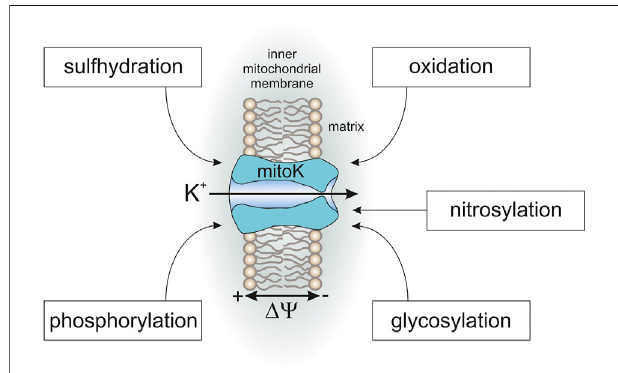
FIGURE 3 | Posttranslational modi fi cations of mitochondrial potassium